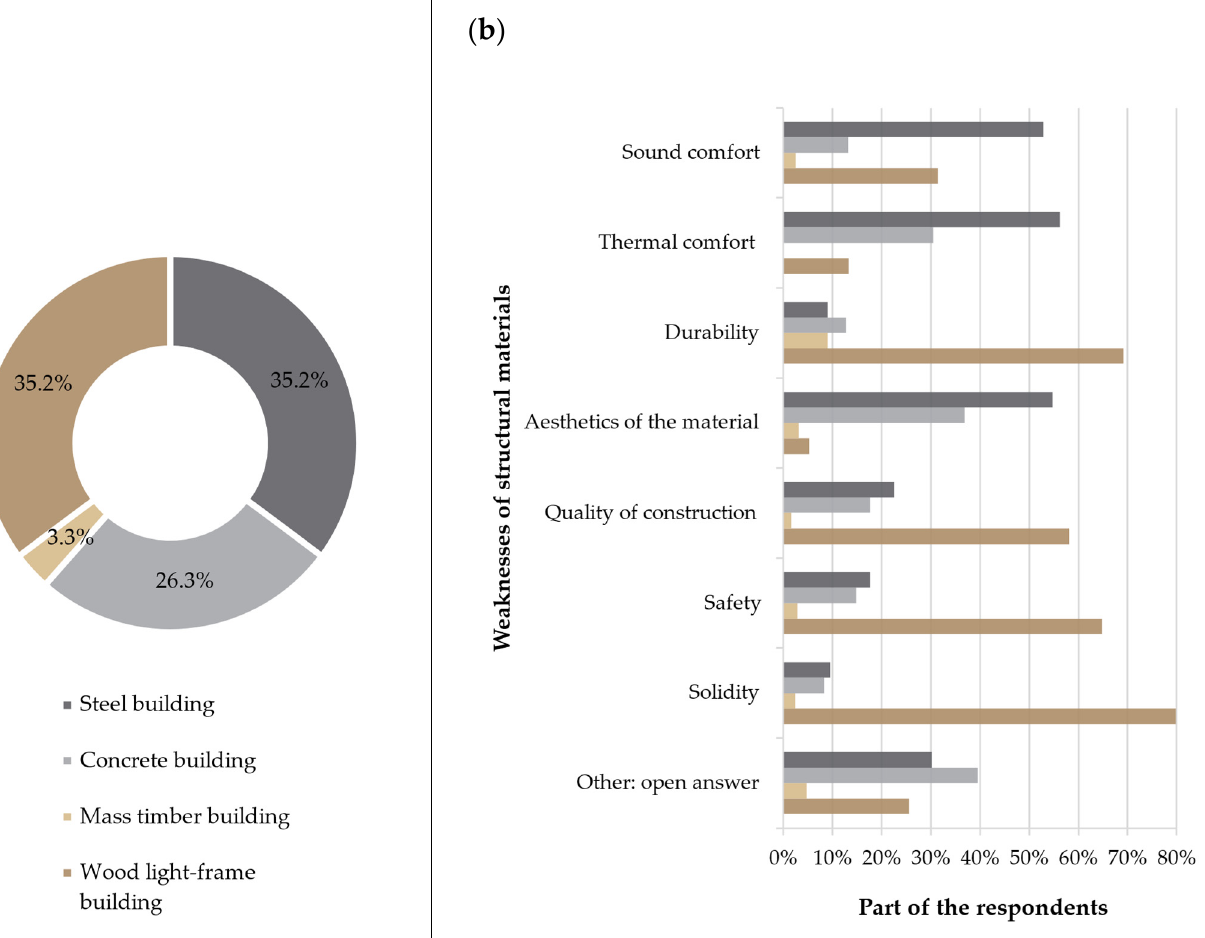
Figure 3. Respondents’ unfavorable preference for different structural materials: ( a ) Buildings in which respondents would least like to live; ( b ) Reasons why respondents would least like to live in these buildings.